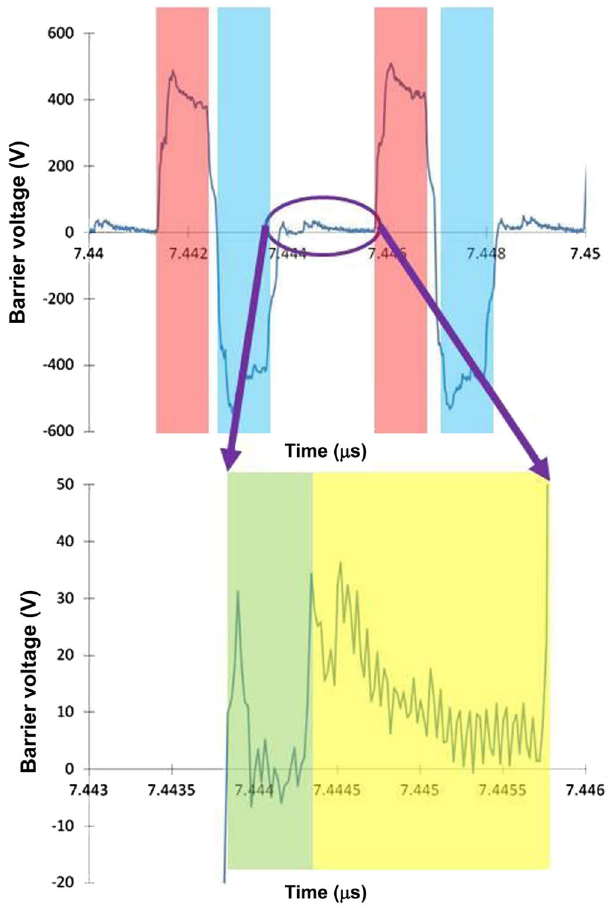
FIG. 9. Barrier voltage pulses used for C 6 þ confinement.